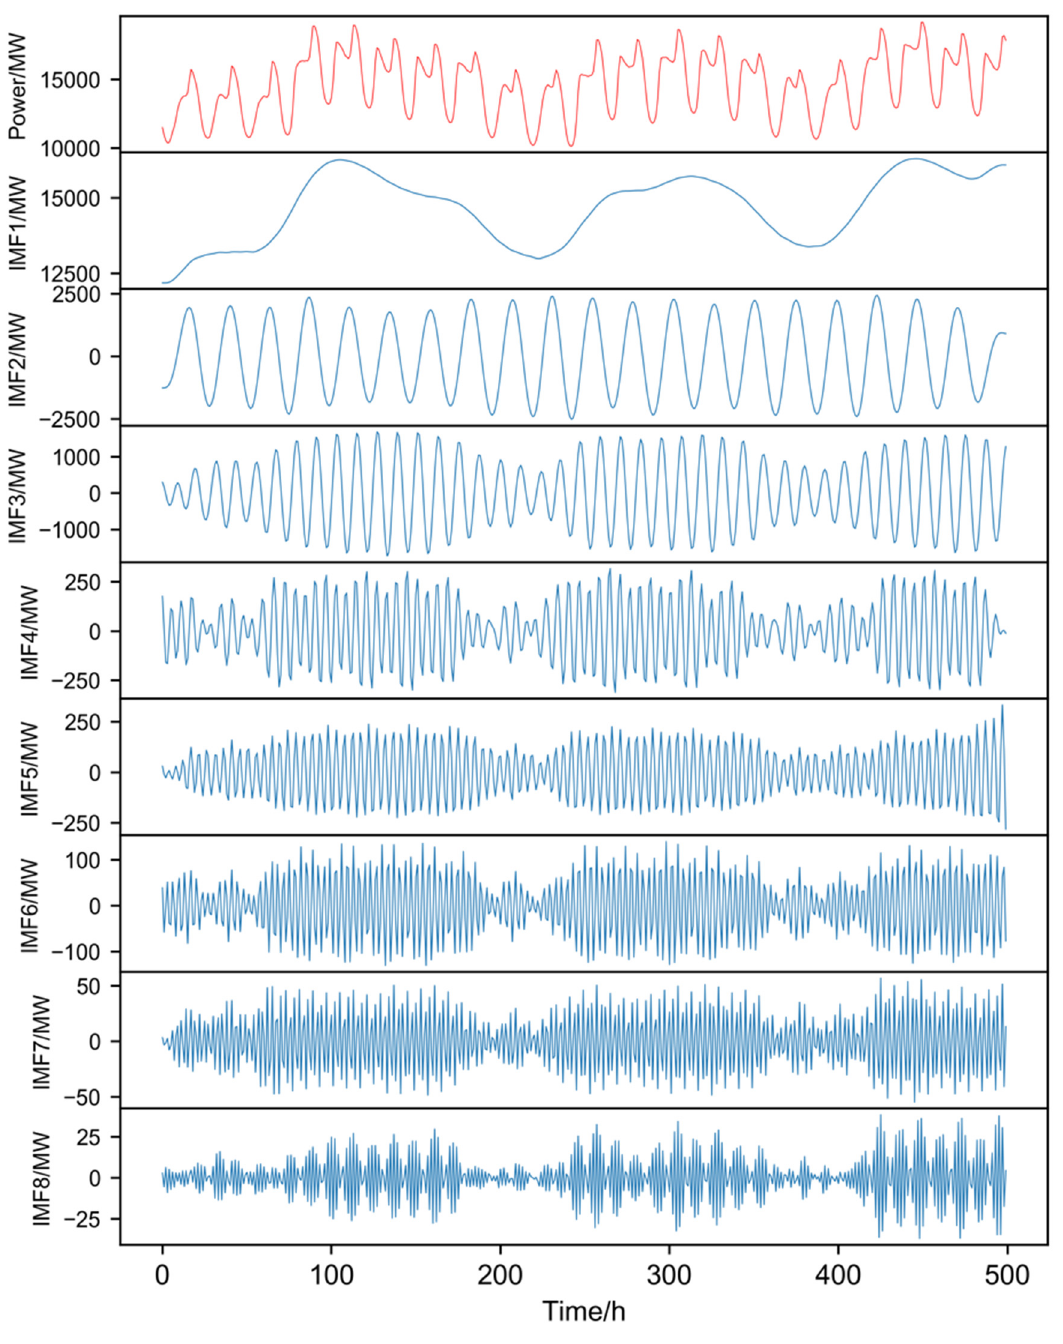
Figure 7. Modal component of